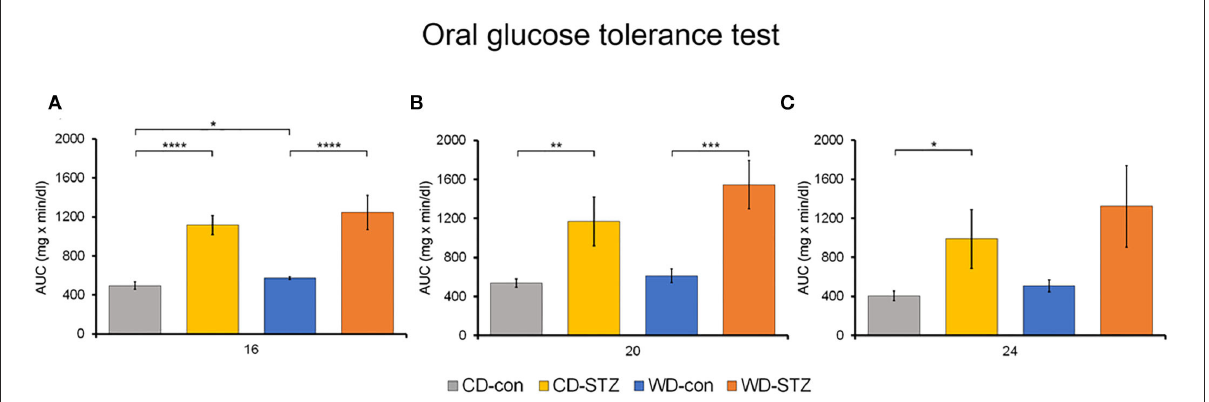
FIGURE4 Oral glucose tolerance test (OGTT). The area under the curve (AUC) after the OGTT was calculated in mice at 16 (A) , 20 (B) , and 24 (C) weeks of age. * p < 0.05, ** p < 0.01, *** p < 0.001, and **** p < 0.0001.